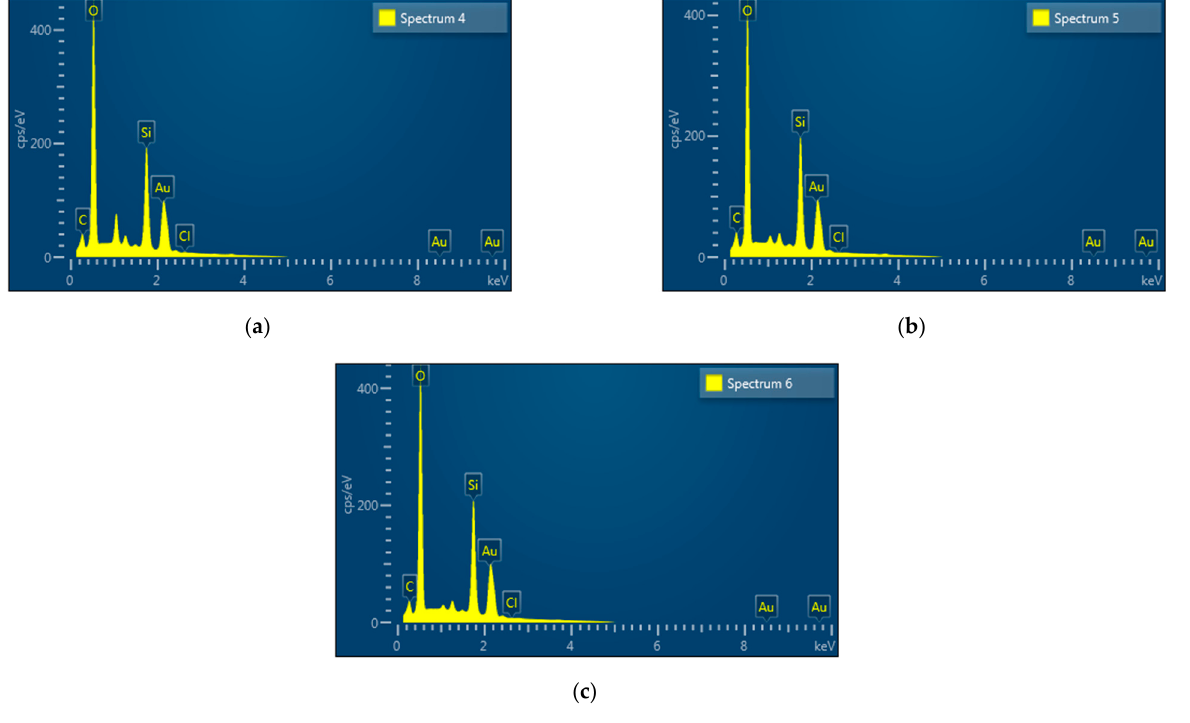
Figure 4. EDX spectra of CCG-NP ( a ) C2, ( b ) C10, ( c ) C16.